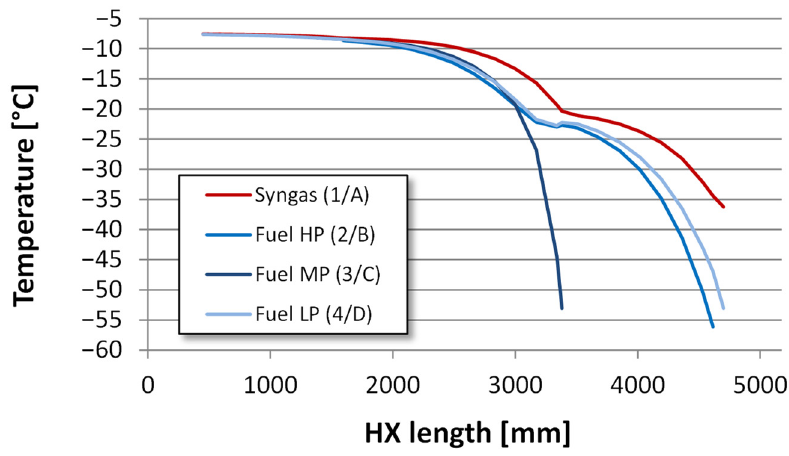
Figure 8. Temperature profiles for plate-fin heat exchanger HX2a.